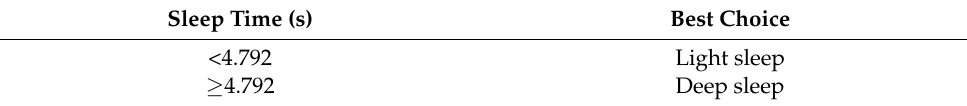
Table 6. Best choice of ESP32 low-power modes under different